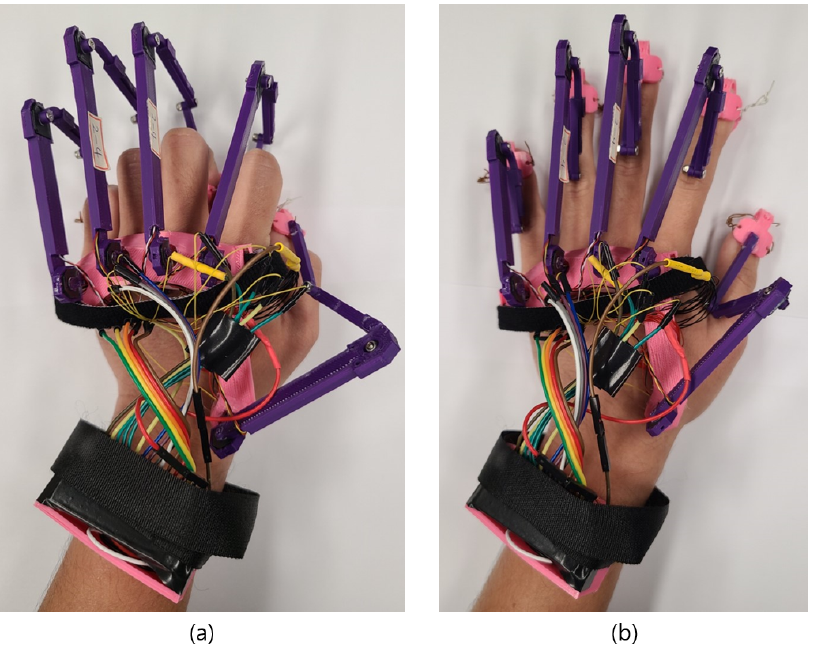
Figure 4. Flexion and extension movements with proposed haptic glove. ( a ) demonstration of flexion movements of 90 ◦ which is considered to be the maximum flexion value in the proposed haptic glove. ( b ) demonstration of extension movements of 0 ◦ which is considered to be the extension value in the proposed haptic glove.